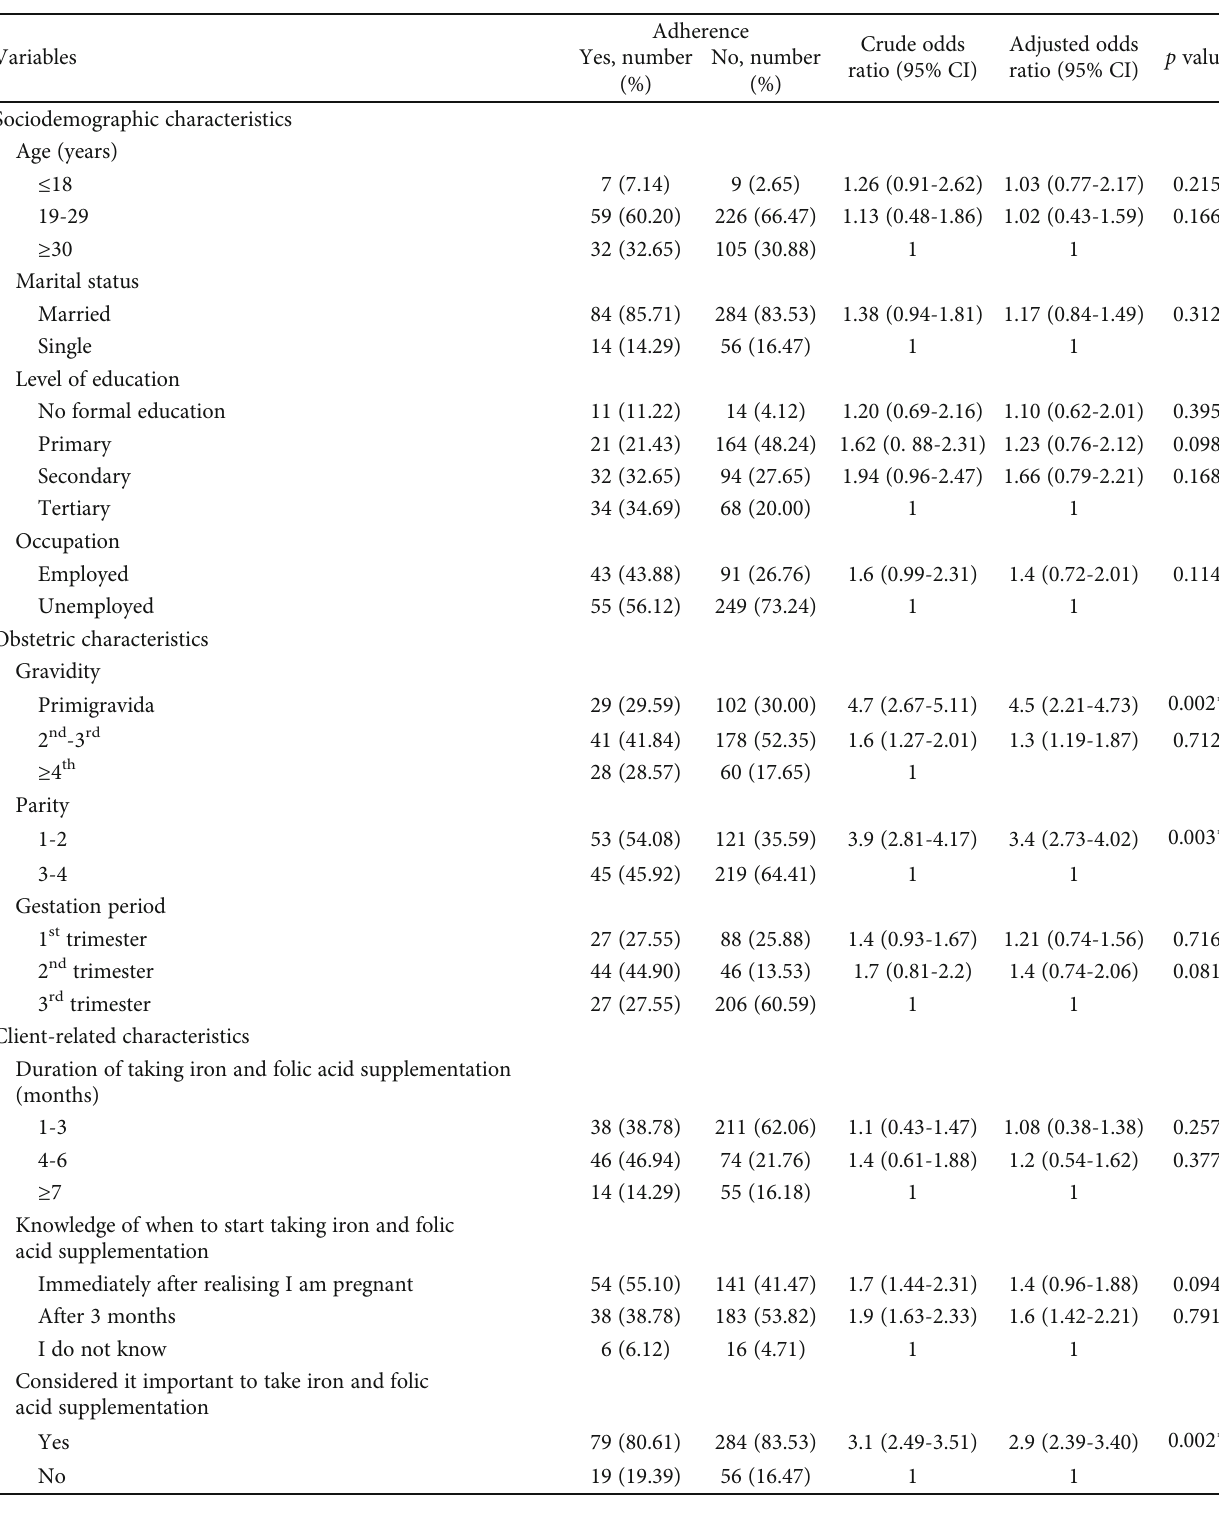
Table 2: Factors associated with iron and folic acid supplementation among pregnant women.